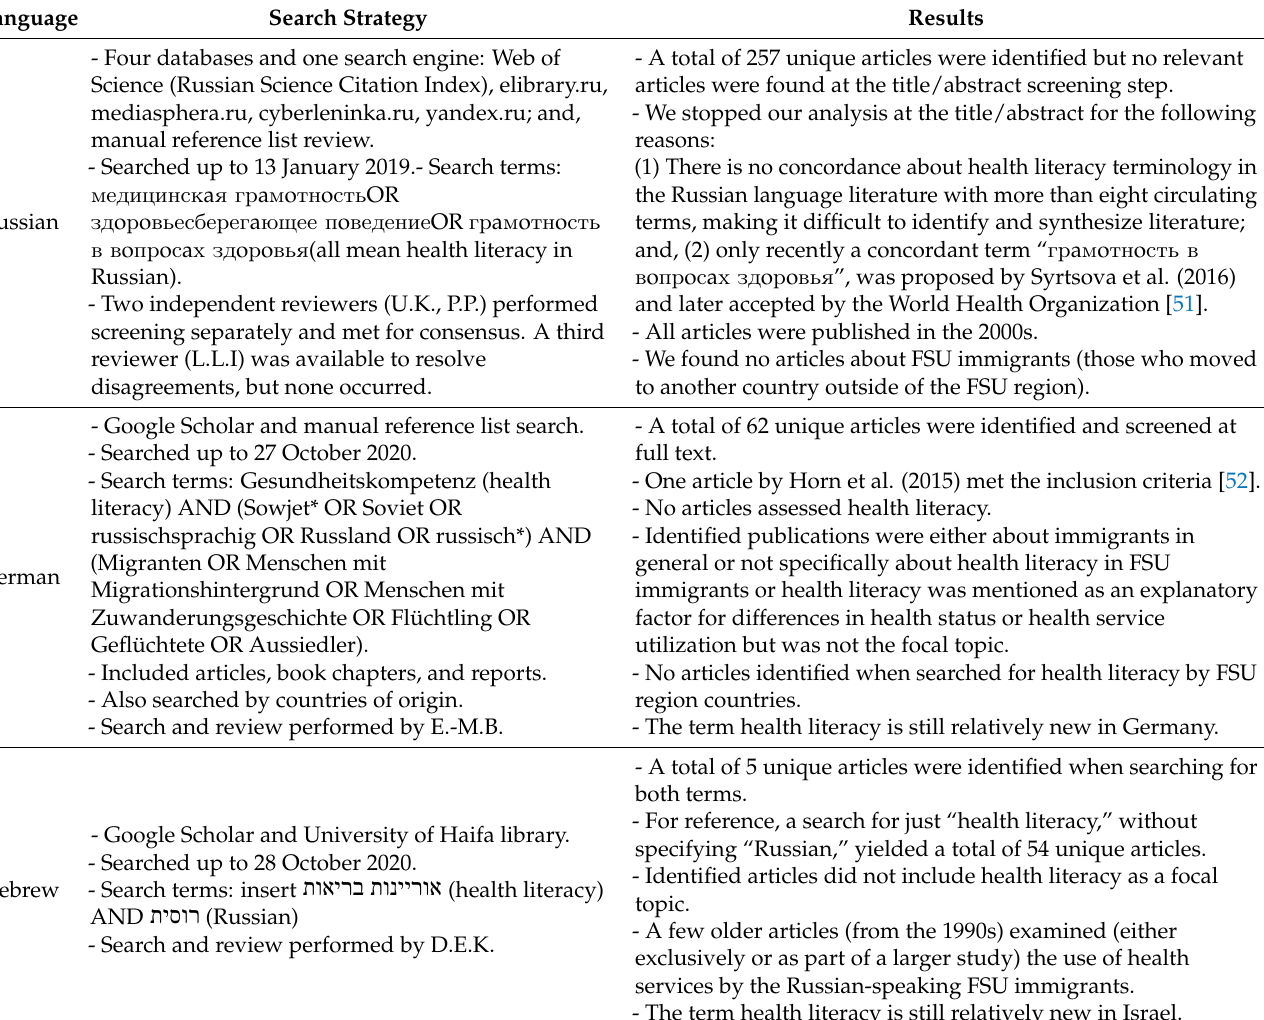
Table 2. Summary of supplemental literature